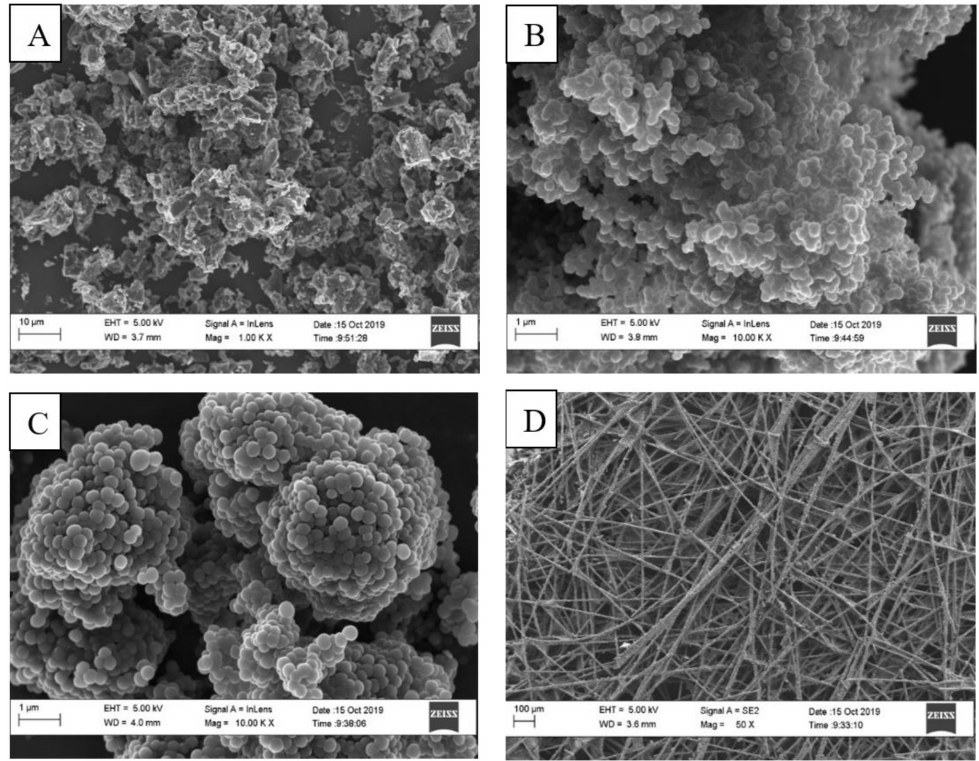
Figure 2. Scanning electron microscopy (SEM) images of ( A ) Activated Carbon (AC) ( B ) Carbon Black (CB) ( C ) Polyvinylidene Difluoride (PVDF) and ( D ) JNT45